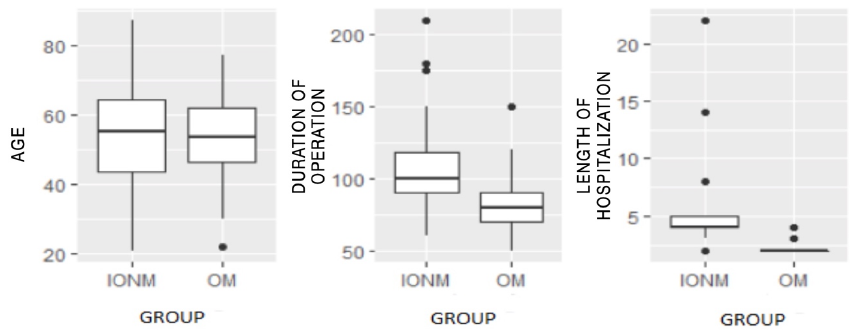
Figure 1. Box and Whisker plots of continuous variables; age, duration of the operation, and length of hospitalization. There were no statistical differences in the median age between the two groups, while for the other variables, there were evident differences.